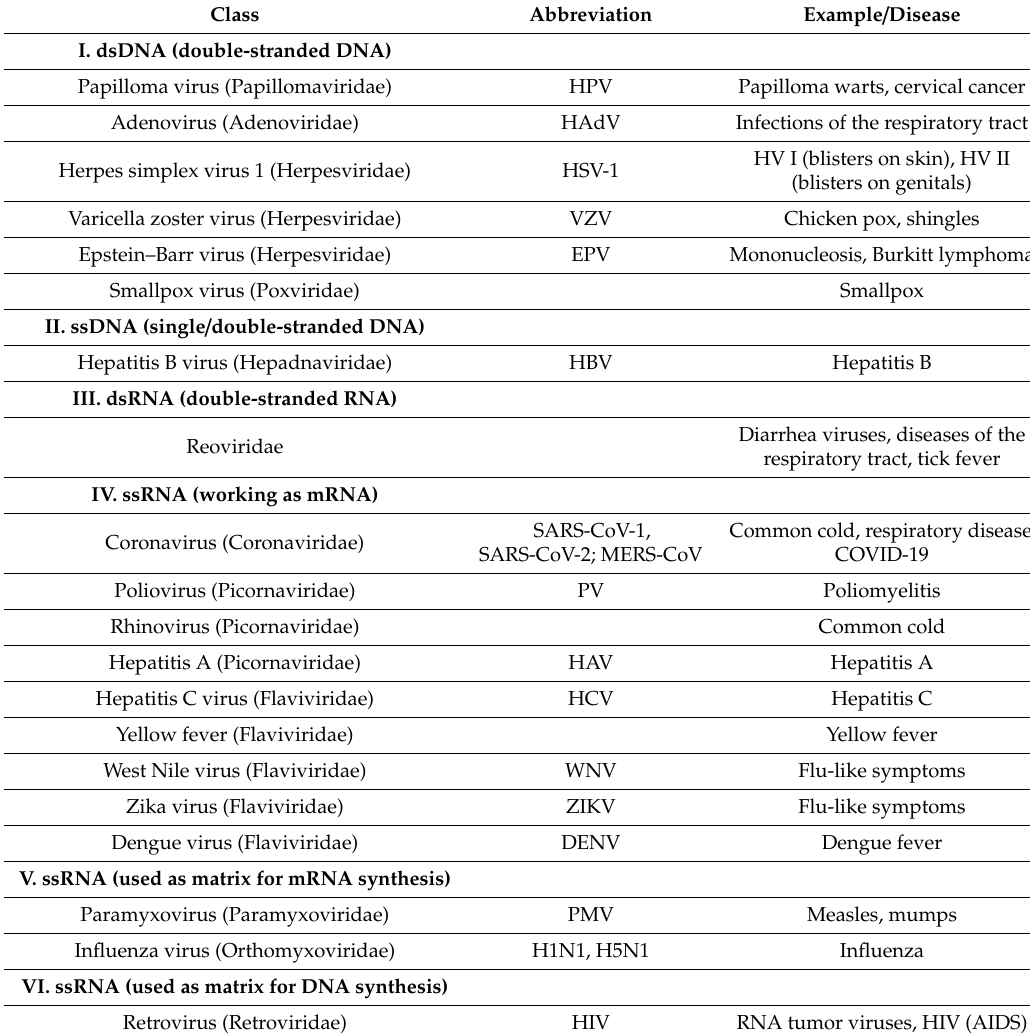
Table 1. Nucleic acids of main groups of viruses and related health disorders